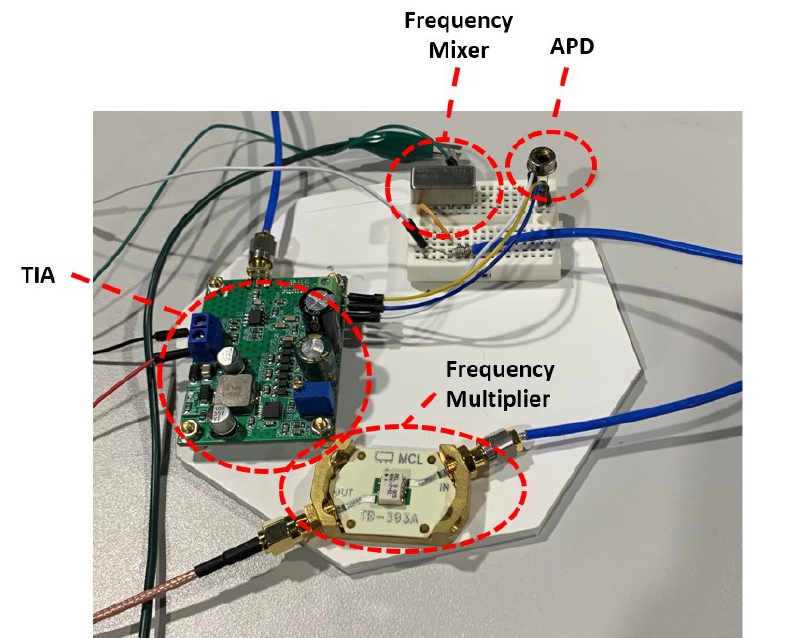
Figure 7. An image of the TIA sensor prototype and its components. On the TIA board, the feedback resistance is adjusted by the potentiometer, and the capacitors are soldered.